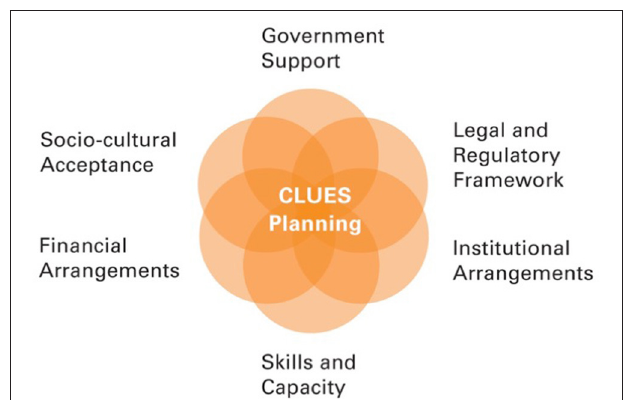
FIGURE 4 | Enabling environment according to CLUES (Source: Lüthi et al., 2011